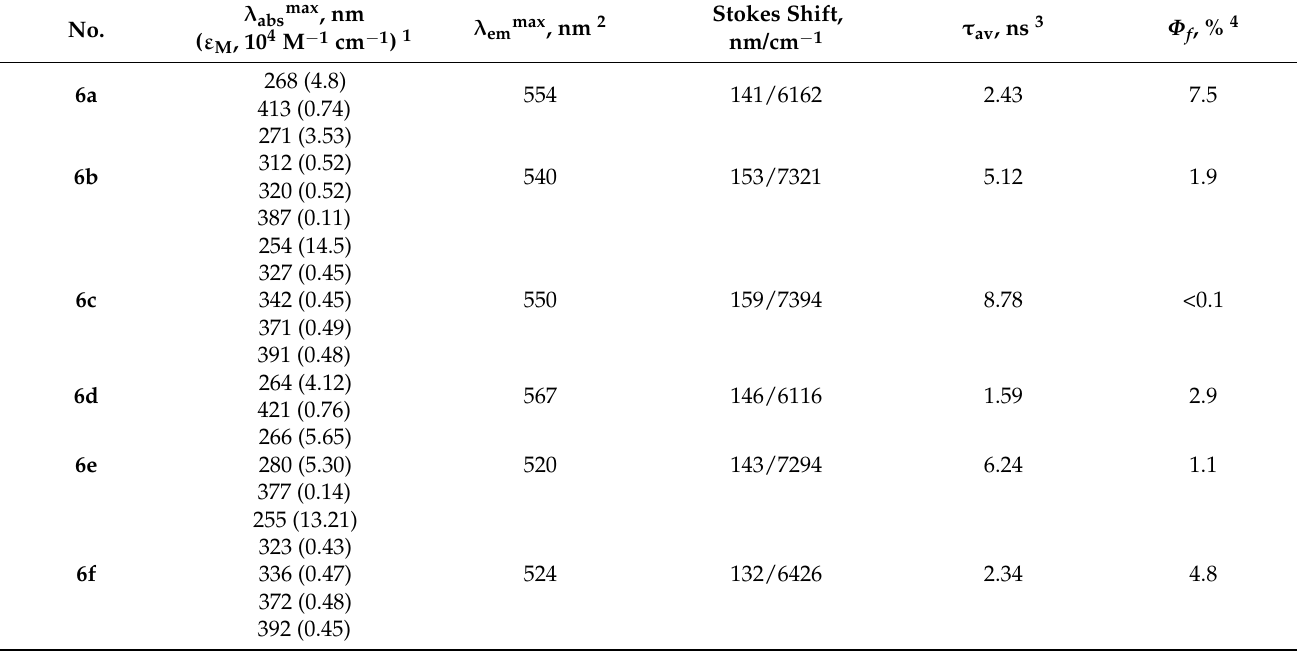
Table 3. Data of photophysical properties of fluorophores ( 6a – f ) (10 − 5 M) in THF solvent.